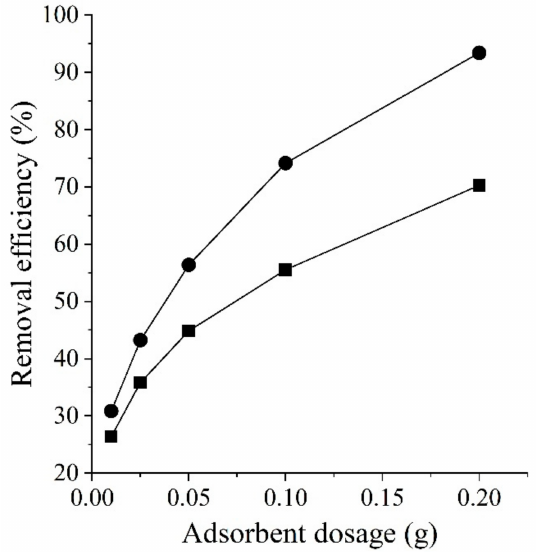
Figure 9. CIP removal as a function of CLI (square) and MAG-CLI (circle) dose ( C 0 = 50 mg dm − 3 , adsorption time = 60 min, T = 298 K and pH =